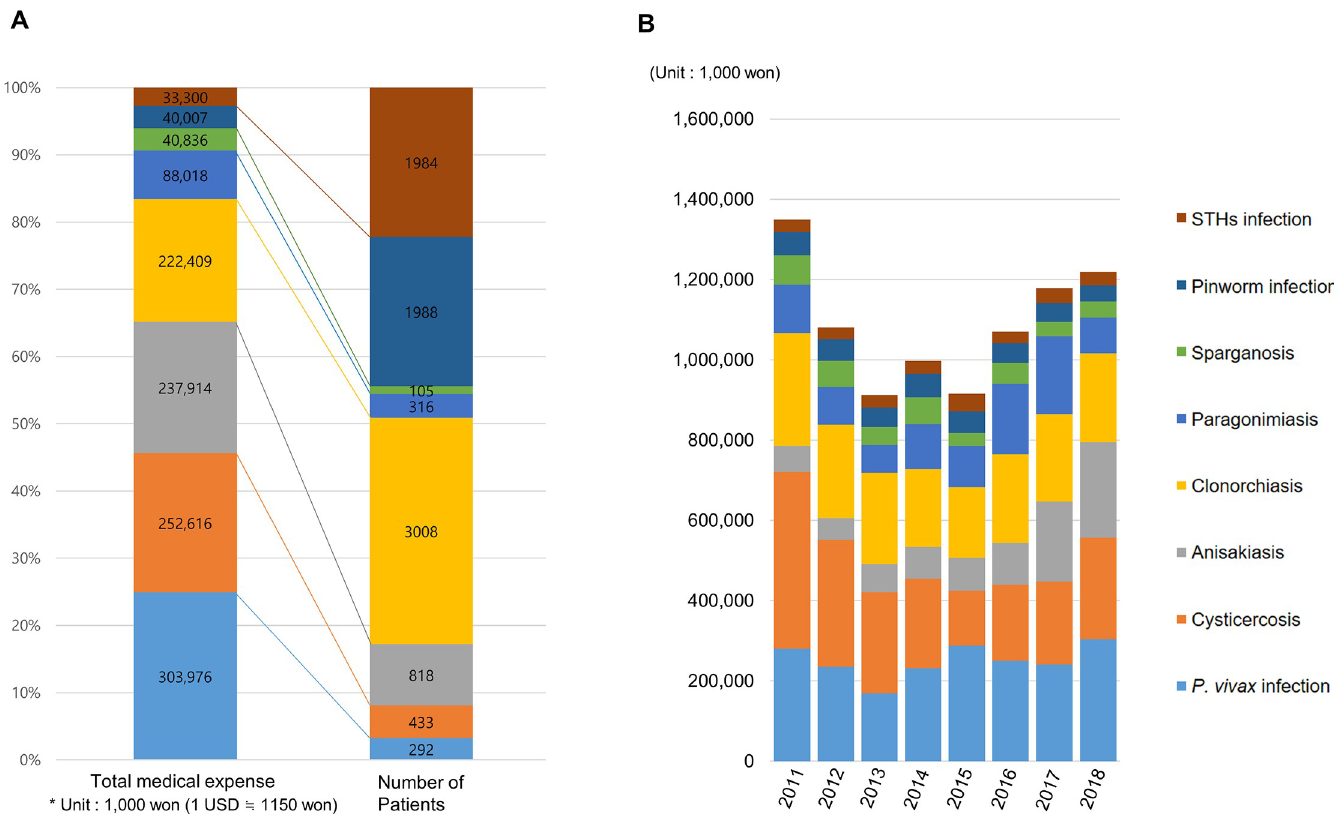
Fig 3. Total medical expense associated with endemic parasitic infections in South Korea. (A) Total medical expense and the number of patients in 2018. (B) Total medical expense from 2011 to 2018. The unit of money is 1,000 Korean won (1 US$ ≒ 1150 won).